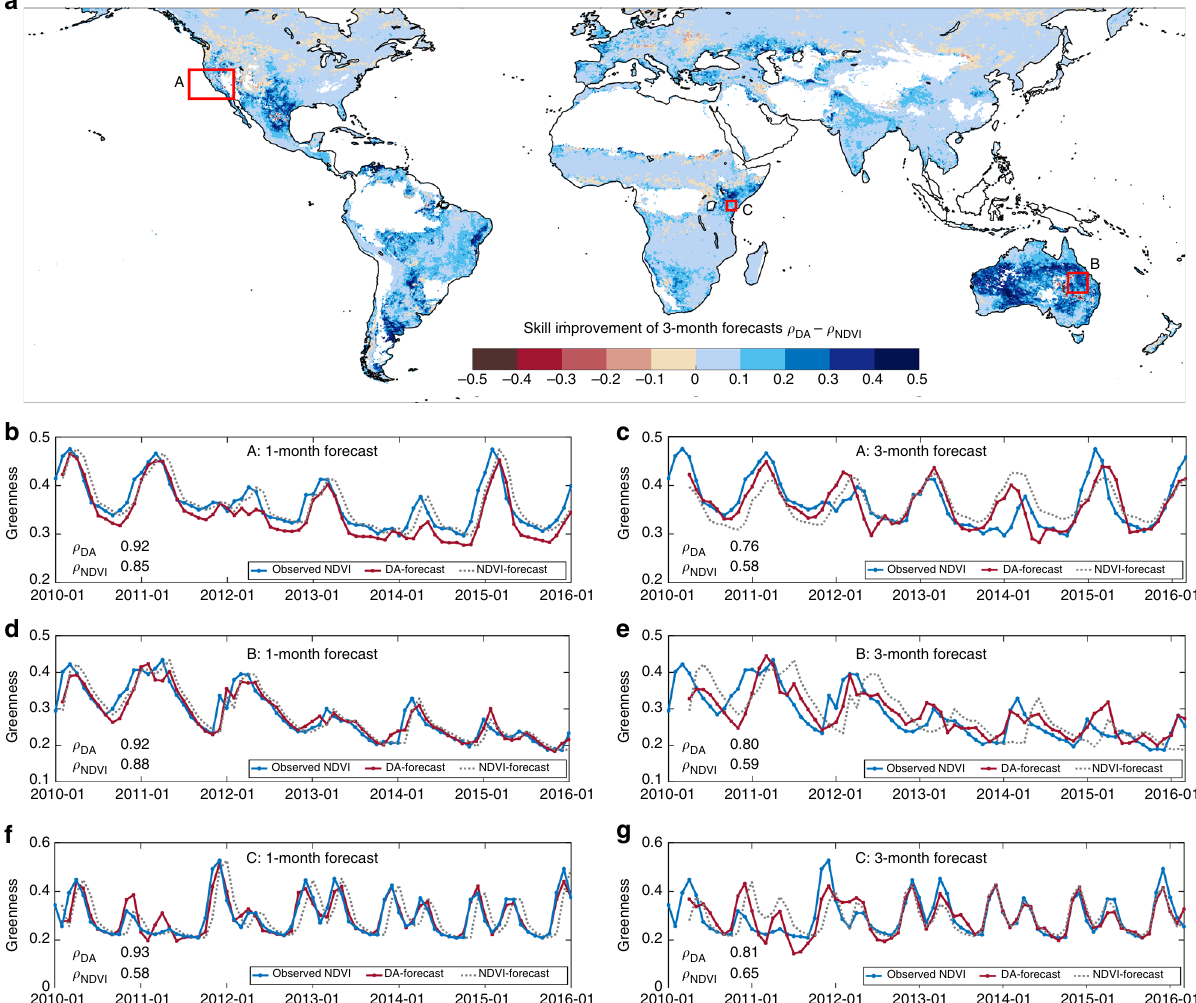
Fig. 3 The 1-month and 3-month forecasts of vegetation condition. a Difference in correlation ( ρ ) between 3-month forecasts using accessible storage (DA-forecast, ρ DA ) and climatology (NDVI-forecast, ρ ) with greenness observations from 2010 to 2016. (DA: data assimilation, NDVI: Normalised NDVI Difference Vegetation Index). b – g Monthly time series of averaged 1-month and 3-months forecasts of greenness, compared with observed vegetation greenness over regions A, B and C in a